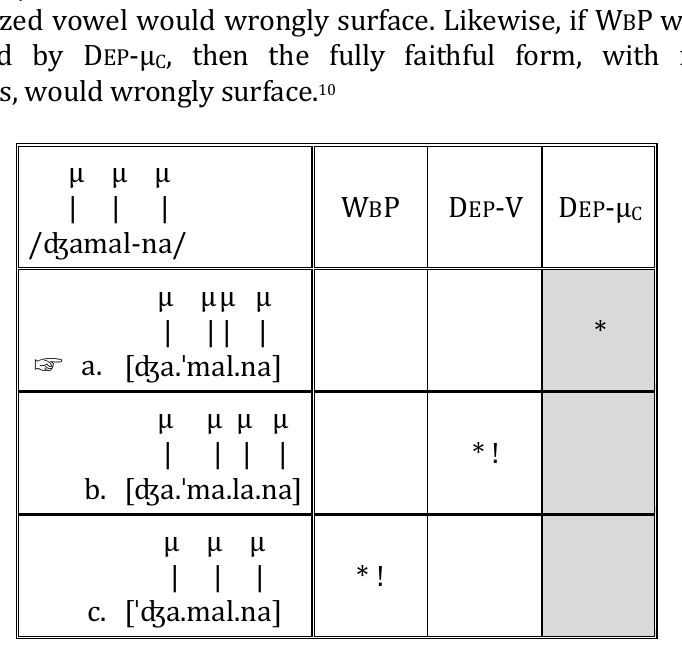
Tableau 3 : Vowel epenthesis does not occur between two consonants which can be syllabified as a singleton onset and a singleton coda, and instead a consonantal mora is